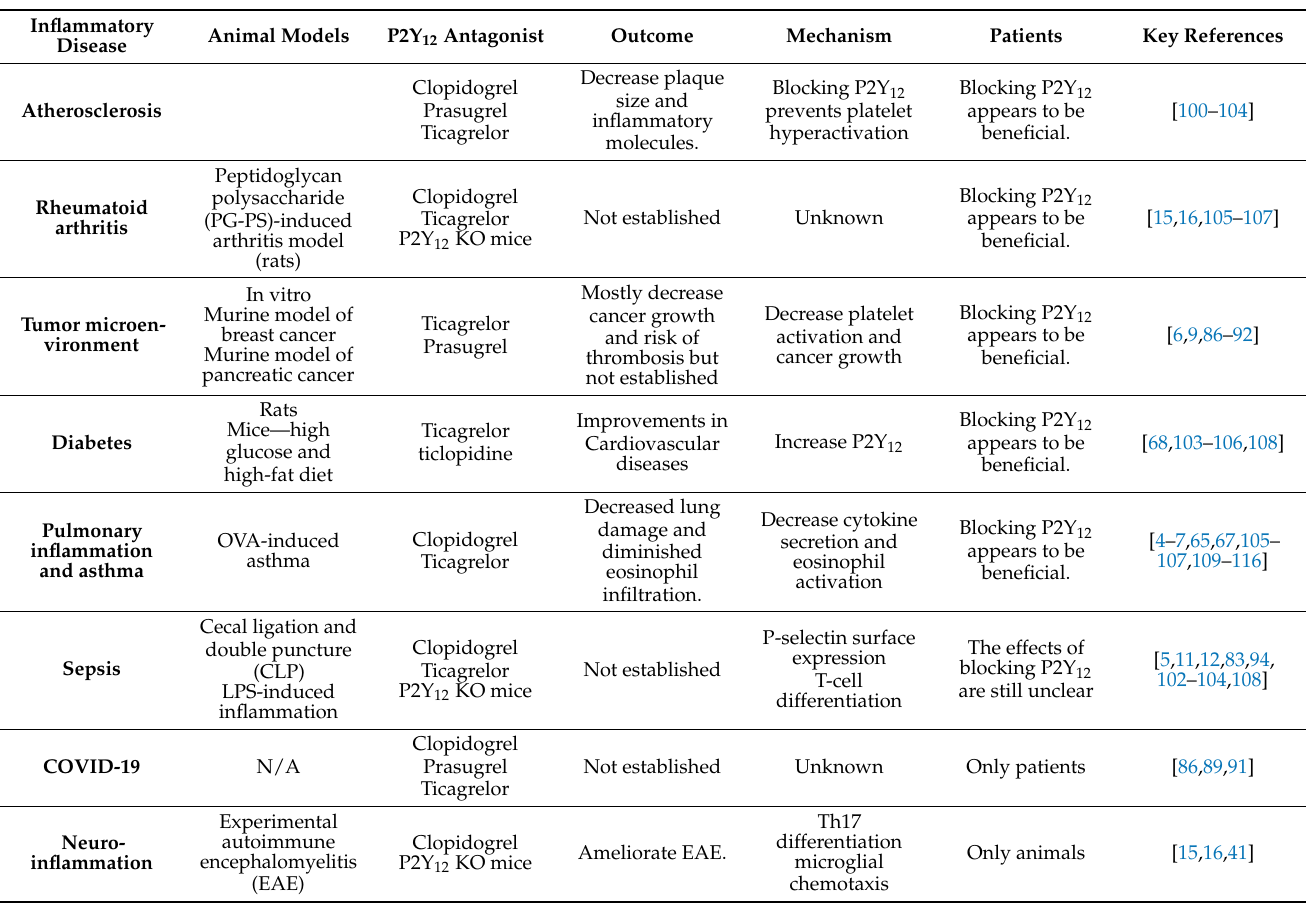
Table 3. P2Y 12 activation in the immune system during inflammatory conditions. This table pro- vides a summary of what is known so far about the effects of P2Y 12 blockage on a number of inflammatory